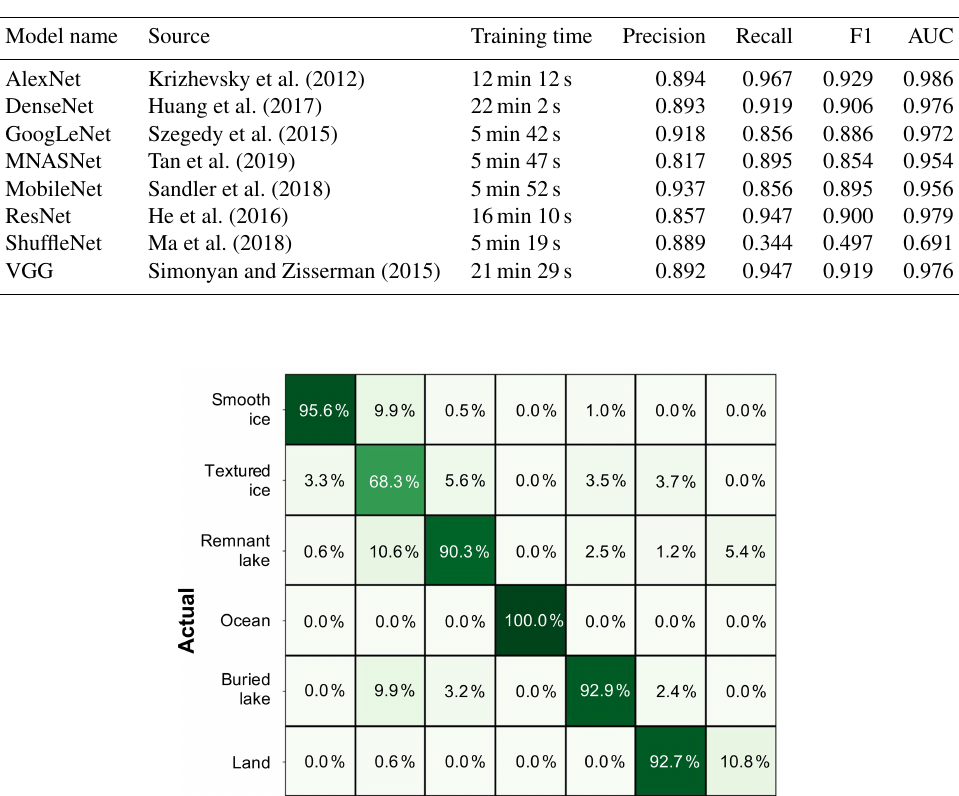
Table A1. Comparison of model evaluation metrics between different CNN architectures.